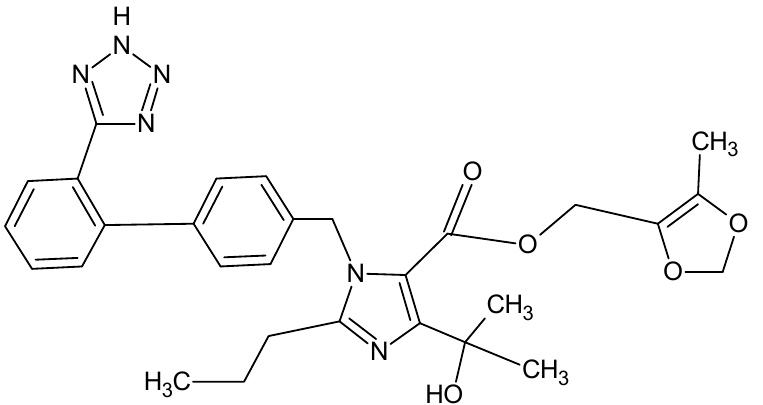
Figure 1. Molecular structure of olmesartan.